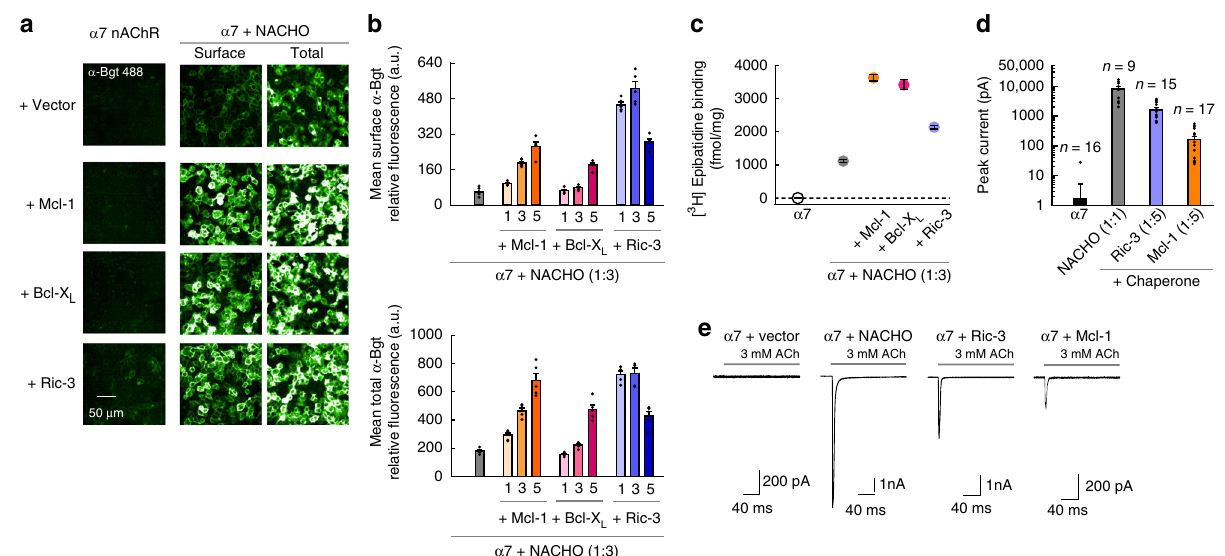
Fig. 1 Bcl-2 proteins enhance assembly and functional expression of α 7 nAChRs. a Immuno fl uorescent staining of HEK293T cells cotransfected with cDNAs encoding α 7, or α 7 and NACHO, along with Mcl-1, Bcl-X L , or Ric-3 (at 1:3:5 cDNA ratio, respectively). Surface and total staining were performed before and after membrane permeabilization, respectively, using α -Bgt conjugated to a fl uorescent probe. b Quanti fi cation of speci fi c α -Bgt labeling, expressed as fl uorescence intensity ( n = 5). cDNA ratios are indicated relative to the α 7-encoding vector. At 5× cDNA ratios, the increase in surface (top) and total (bottom) α -Bgt labeling produced by Mcl-1, Bcl-X L , or Ric-3 cotransfection was signi fi cant ( p < 0.001). The same cDNA combinations were transfected at different passage numbers and yielded similar results. c Binding of 10 nM [ 3 H]epibatidine to HEK293T cell membranes cotransfected with α 7, NACHO, and other proteins as indicated (at 1:3:5 cDNA ratio, respectively), with measurements taken from multiple samples during a